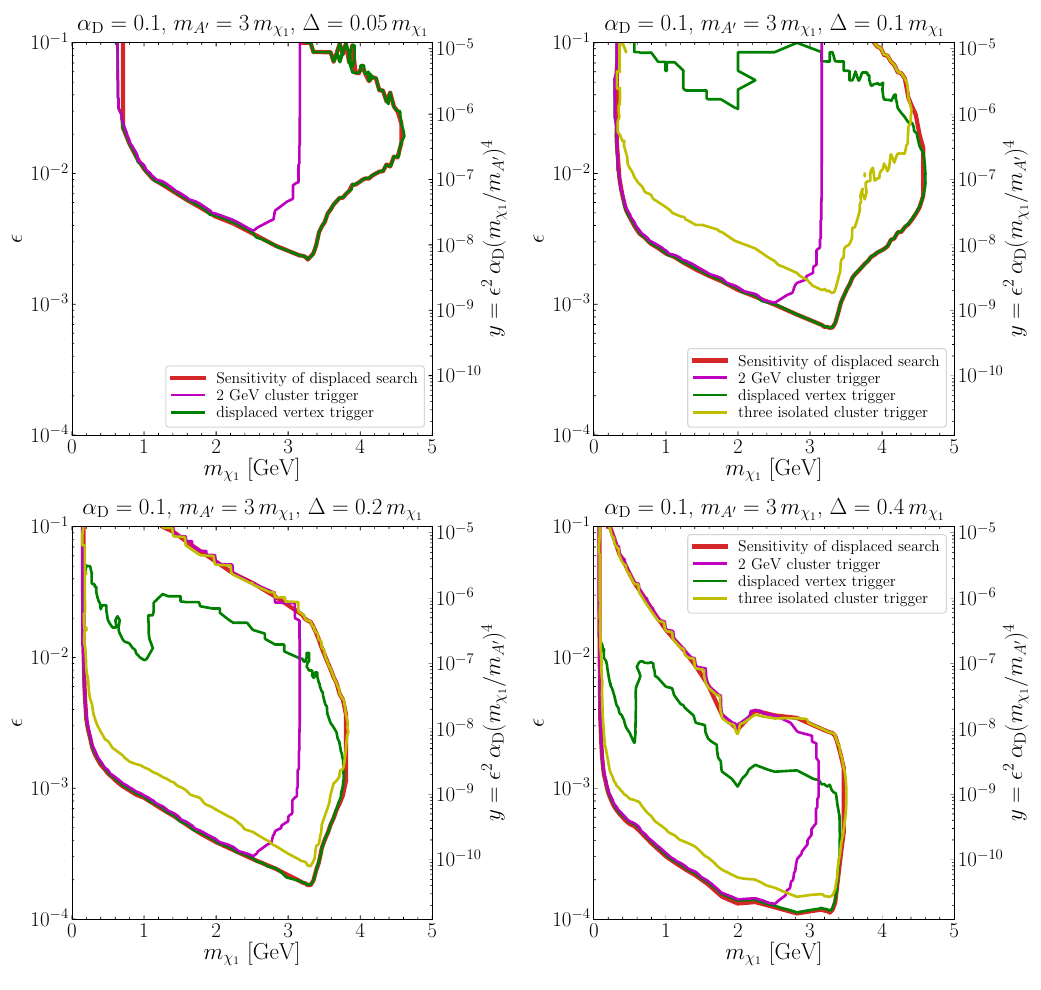
Figure 7 . Sensitivity of the displaced search (same as (cid:12)gure 5, but with linear horizontal axis), overlaid with the regions where the various triggers are e(cid:14)cient for an integrated luminosity of 20 fb (cid:0) 1 for m A = 3 : 0 m (cid:31) . 1 0 speci(cid:12)c to the assumed ratio of m (cid:31) and m A 0 . For m A 0 = 3 m (cid:31) , for example, the thermal 1 1 target is already partially excluded by the constraint from BaBar (see (cid:12)gure